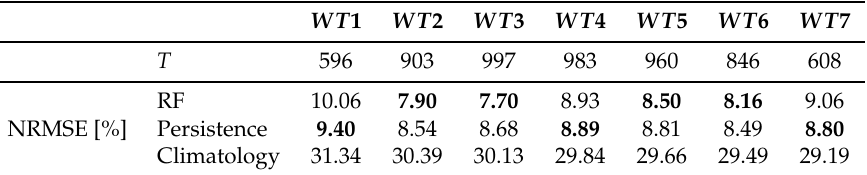
Table 4. Normalised root-mean-square-error (NRMSE), in % of the nominal capacity ( P n ), of the five-minute ahead forecasts for the seven turbines of the first row. T indicates the number of periods evaluated. Minimum values are shown in bold. Results are shown for the remote sensing-based forecasting (RF) model, persistence and climatology benchmarks.